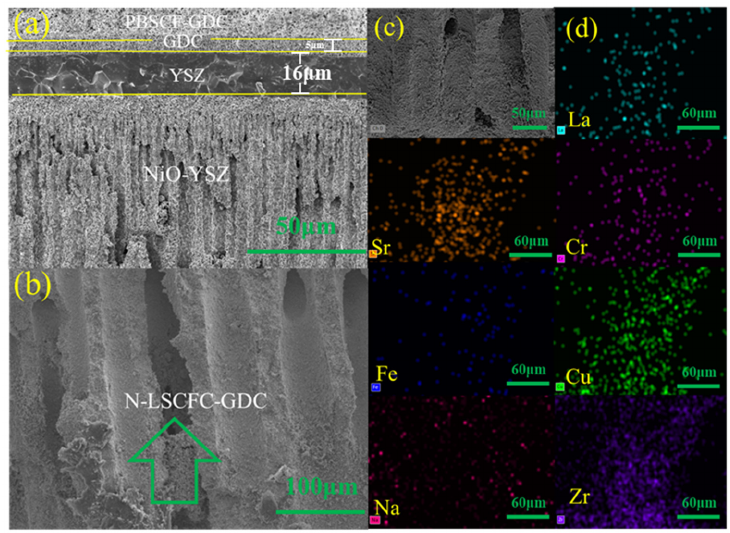
Figure 5. SEM microstructure and EDS element analysis of single cell with N-LSCFC-GDC reforming catalyst: ( a ) triple structure; ( b ) dendritic anode with N-LSCFC-GDC reforming catalyst; ( c ) image for EDS; and ( d ) elemental mappings for ( c ).